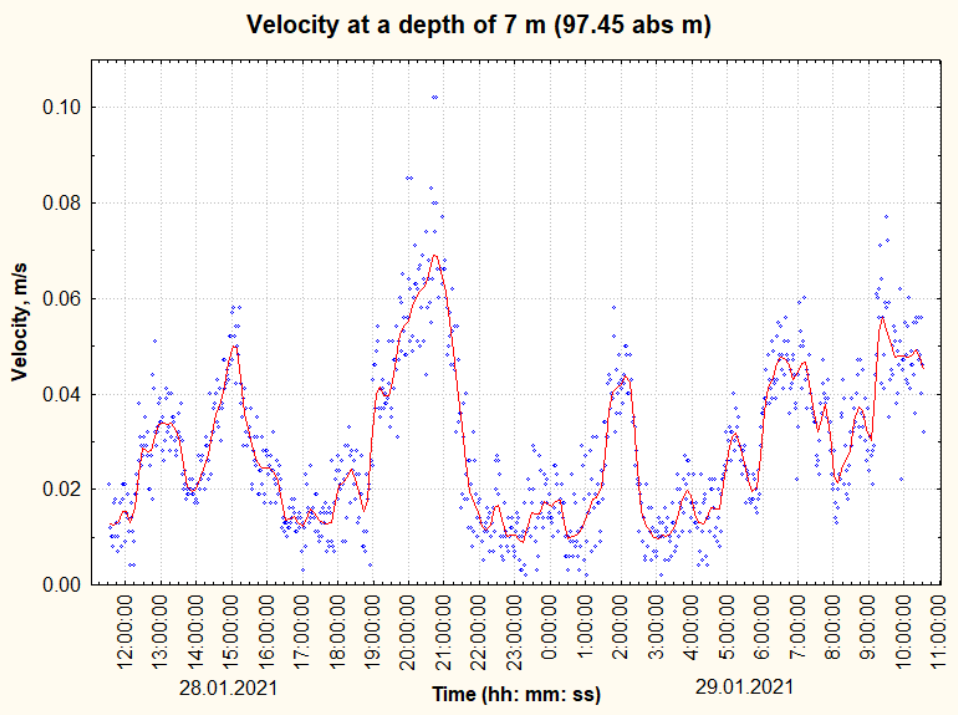
Figure 4. Changes in the flow velocity modulus (m/s).